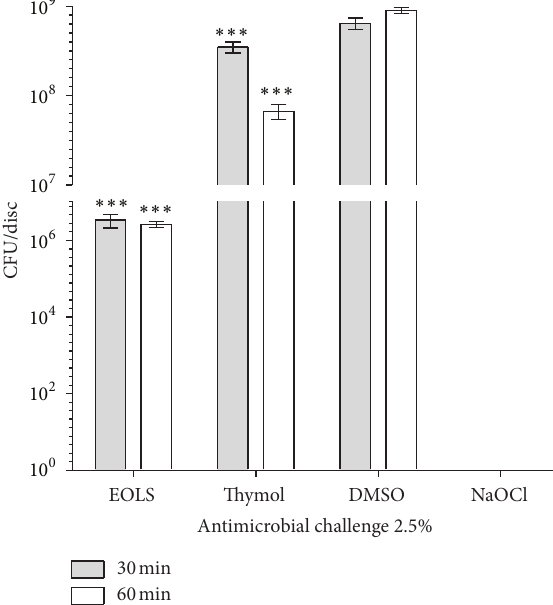
Figure 2: Susceptibility of biofilms of Enterococcus faecalis to antimicrobial challenge at 10.0% (v/v) for 30 or 60 min exposure times. EOLS, essential oil of Lippia sidoides ; DMSO, dimethylsulfox- ide (negative control); and NaOCl, sodium hypochlorite (positive control). The vertical bars indicate the standard deviation ( 𝑛 = 3 ). ∗∗∗ 𝑃 < 0.001 compared with DMSO (two-way ANOVA followed by the Bonferroni